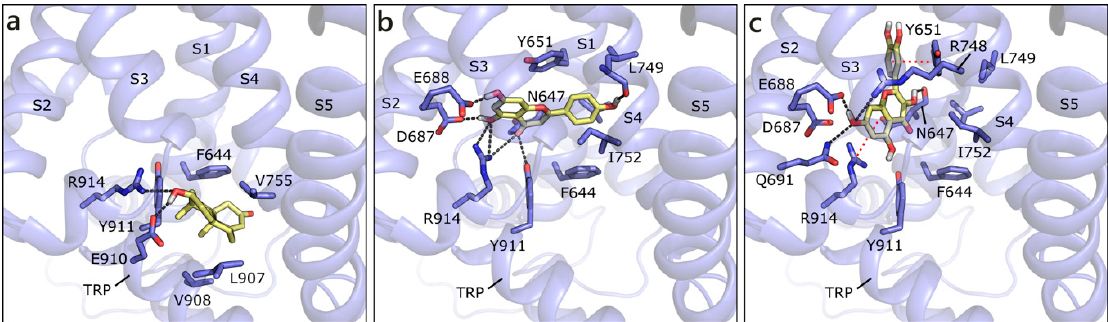
Figure 11. Docking poses of T ( a ), API ( b ), and QRC ( c ) in TRPM8 model. The protein is shown in transparent purple cartoon, the residues lining the binding site and the ligands are shown in capped sticks and colored purple and yellow, respectively. Helices and residues lining the pocket are labelled, hydrogen bonds are displayed as black dashed lines.